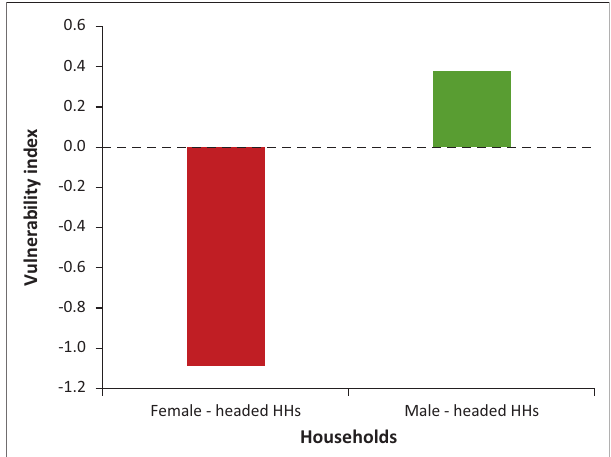
FIGURE 4: Vulnerability of households by gender. HHs,